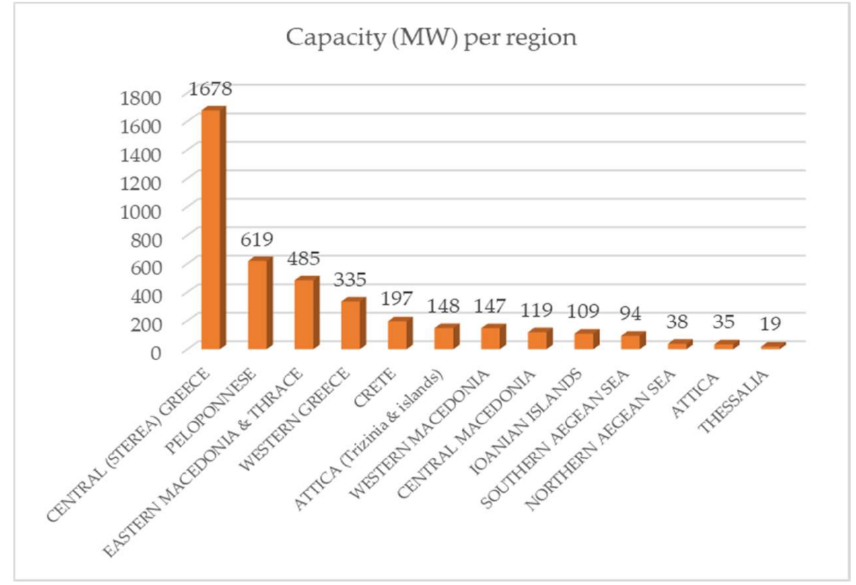
Figure 7. Wind capacity per region in Greece